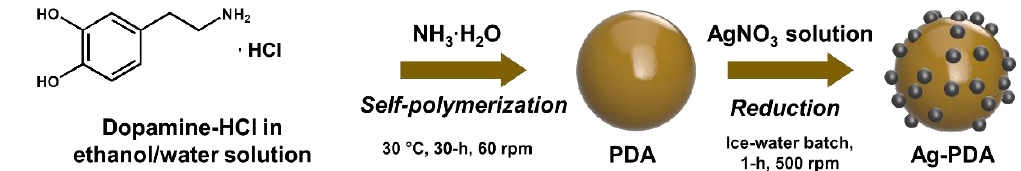
Figure 1. Synthesis of polydopamine (PDA) and Ag-PDA particles. PDA particles were centrifuged and washed before the functionalization of Ag on its surface.